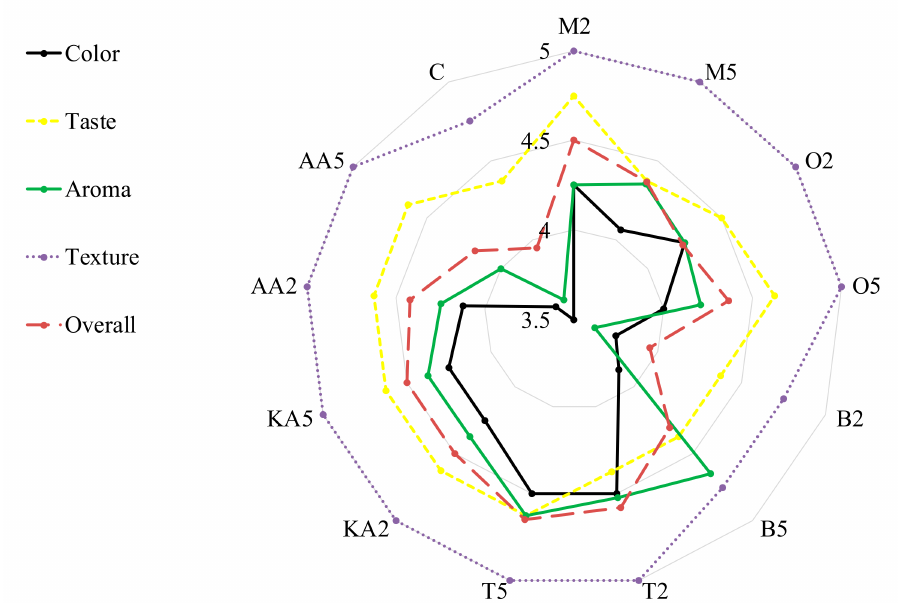
Figure 2. Consumer evaluation of analyzed stored mung bean sprouts. M2, M5: mung bean sprouts soaked in 2IC50 and 5IC50 water extracts of marjoram leaves, respectively; O2, O5: mung bean sprouts soaked in 2IC50 and 5IC50 water extracts of oregano leaves, respectively; B2, B5: mung bean sprouts soaked in 2IC50 and 5IC50 water extracts of basil leaves, respectively; T2, T5:mung bean sprouts soaked in 2IC50 and 5IC50 water extracts of thyme leaves, respectively; KA2, KA5: mung bean sprouts soaked in 2IC50 and 5IC50 solutions of kojic acid; AA2, AA5: mung bean sprouts soaked in 2IC50 and 5IC50 solutions of ascorbic acid; C: mung bean sprouts soaked in distilled